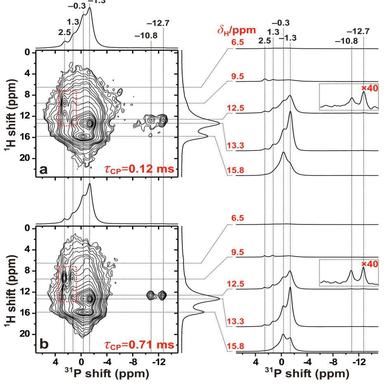
31P HETCOR NMR spectra, obtained from the MonB cement at 34.00 kHz MAS and 1 H→31P CP contact time-periods of (a) CP = 118 μs and (b) CP = 706 μs, and shown together with projections along the 31P (horizontal; top) and 1 H (vertical; right) spectral dimensions. The right panel displays slices along the 31P dimension, extracted at the as-indicated 1 H chemical shifts (δH). The red box encircle the six 1 H/31P correlation peaks from NaH2PO4 at shift coordinates of , , , , , . (For interpretation of the refer